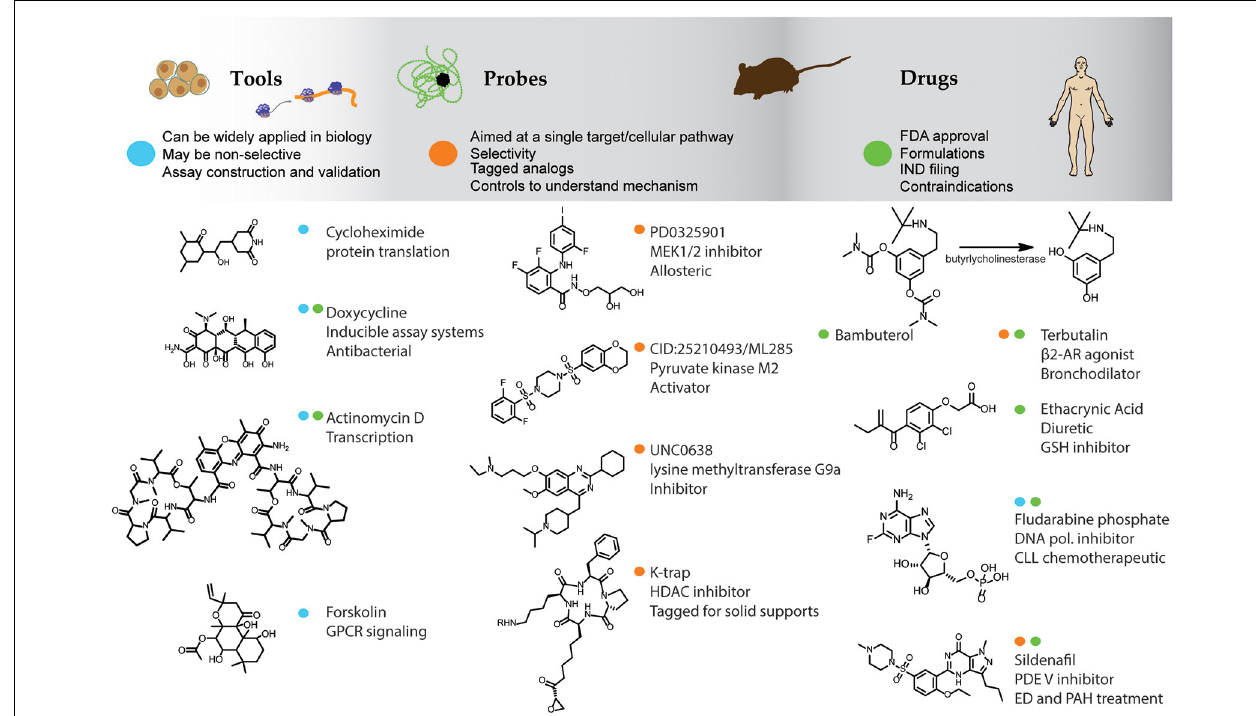
FIGURE 1 | Small molecules as tools, probes, and drugs. The top bar lists some general features of compounds used as tools, probes, and drugs and example compounds are listed underneath. Color dots designate the primary use of the compounds as a